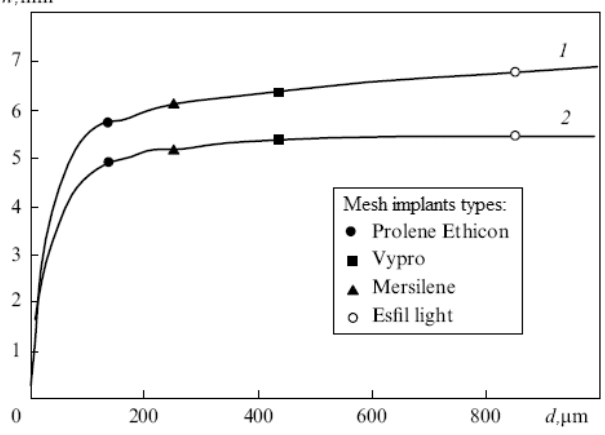
Fig. 4. Dependence of the limiting visualization depth ð h Þ of mesh implant structure from the e®ective cell diameter ð d Þ and medium characteristics. Scattering and absorption coe±- cients are (1) 60 and 0.34 mm (cid:1) 1 and (2) 45 and 0.44 mm (cid:1) 1 ,